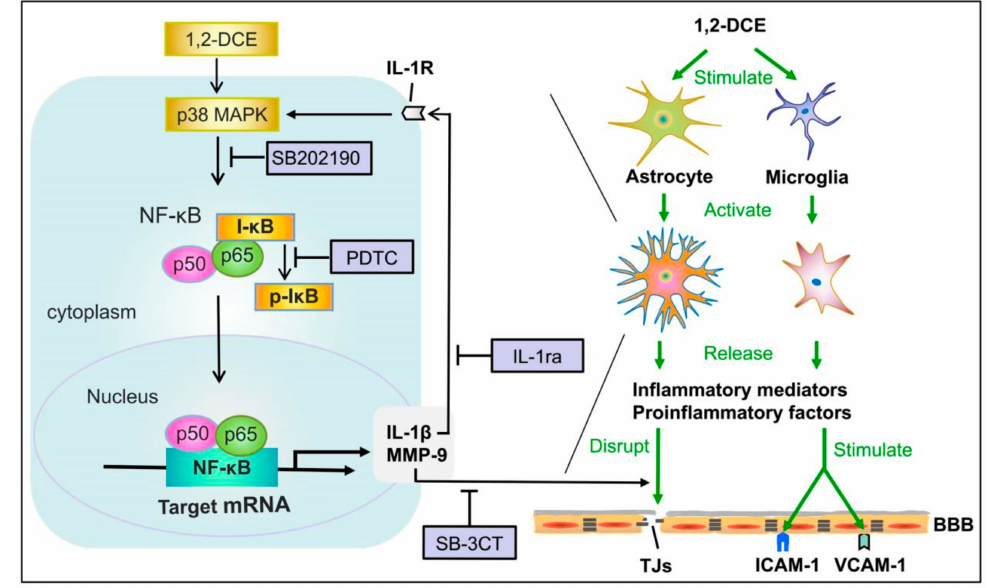
Figure 9. Schematic